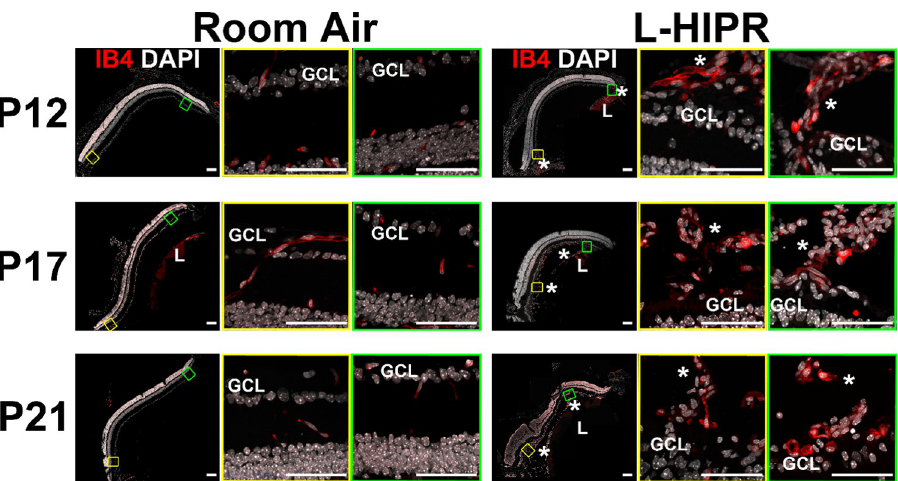
Fig 4. The hyaloidal vessels persist and rescue the retinal vasculature in L-HIPR. Retinal cross sections in room air and L-HIPR groups ( n = 3) were stained with Isolectin B4 (IB4; red), and DAPI (white) at P12, P17 and P21. Central (yellow box) and peripheral (green box) zoomed retinal cross-sections are presented. The hyaloidal vessels were absent, with normal retinal vascular stratification by P12 in the room air eyes. In L-HIPR, the hyaloidal vessels persisted well into P21 and started to invade the peripheral retina at P12 (Asterisks). The later timepoints further illustrate how the hyaloidal vessels invade the mid-retina at P17 and P21. Scale bar 50 μ m, GCL: ganglion cell, � : hyaloid, L: